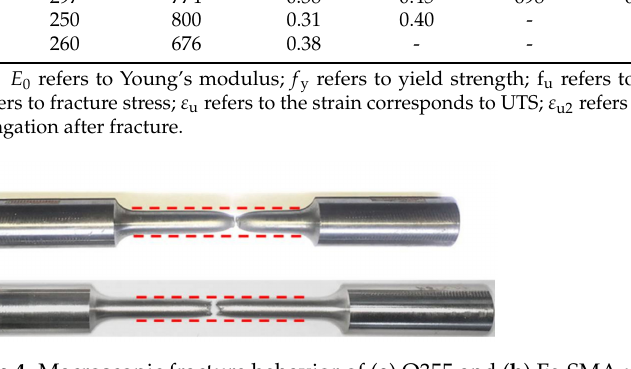
Figure 4. Macroscopic fracture behavior of ( a ) Q355 and ( b ) Fe-SMA under monotonic loading.